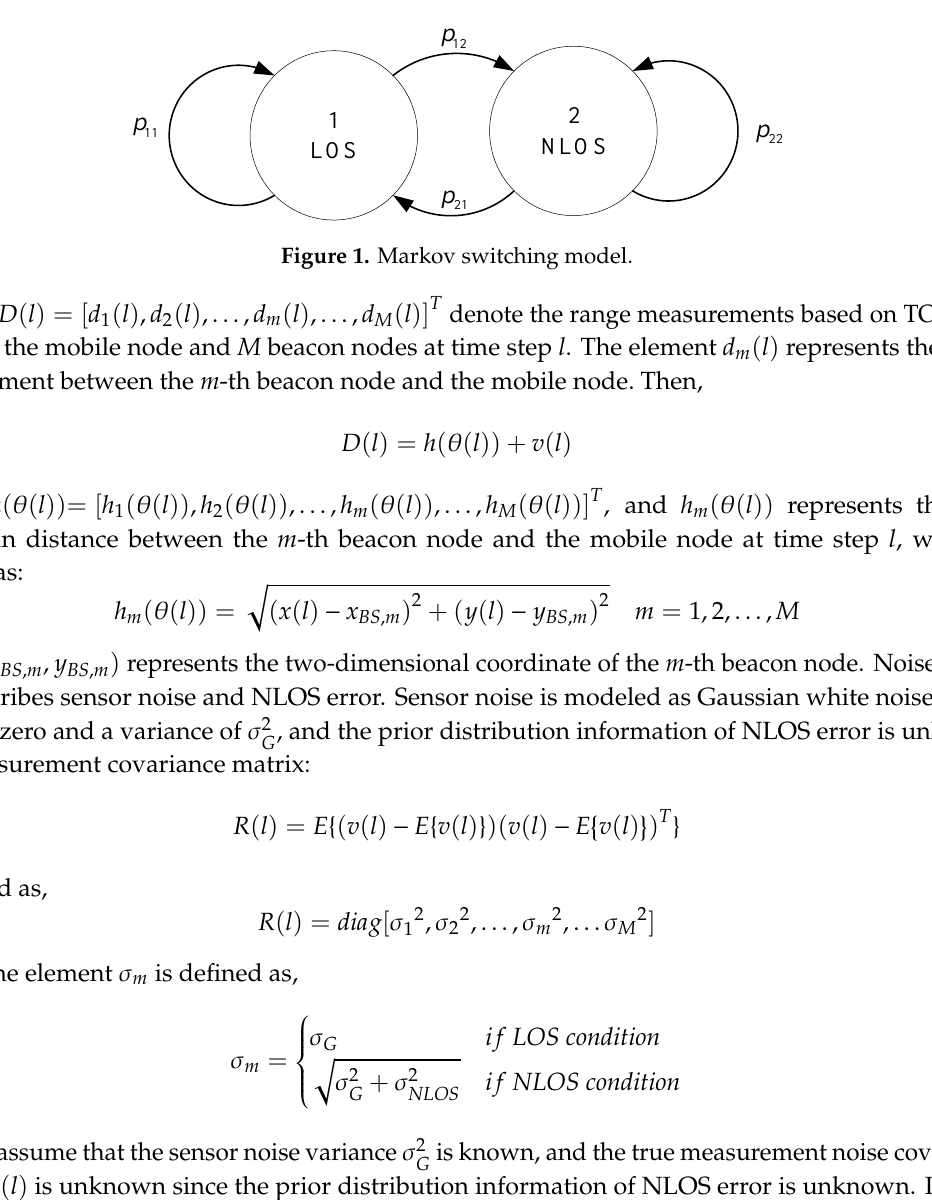
and NLOS model. Because it combines the localization results of LOS and NLOS models, the IMM algorithm is suitable for localization in the hybrid situation of LOS and